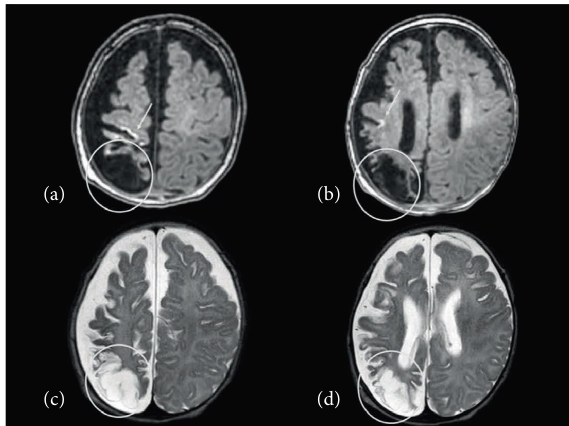
Figure 3: Head MRI. (a, b) T1-weighted MRI; (c, d) T2-weighted MRI. Parasagittal cerebral injury and ulegyria in the right parietal lobe and occipital lobe were observed. Arrows indicate parasagittal injury and circles indicate